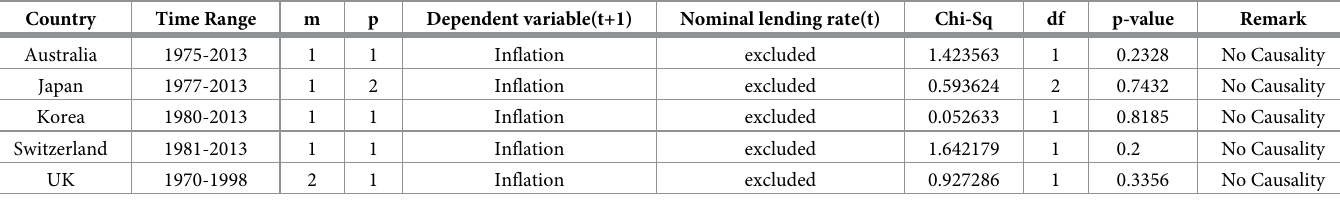
Table 20. VAR Granger Causality/Block Exogeneity Wald Test (Fisherian model).